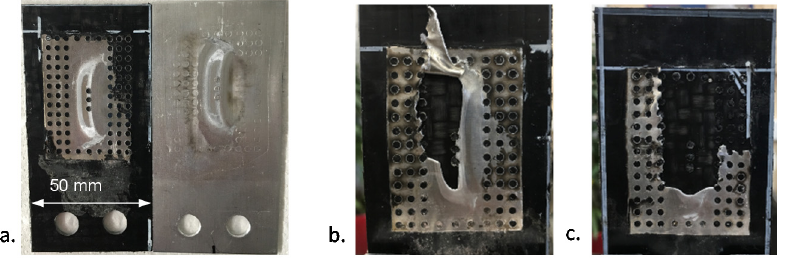
Figure 11. ( a ) Welding coincidence with the holes of the metallic insert (1 mm thick insert); ( b ) Tearing in aluminum metallic insert during dynamic tests when welding is in coincidence with the holes ( b ) or not in coincidence ( c ). Table 6. Quasi-static lap-shear tests for metallic insert configuration (E = 16 kJ).